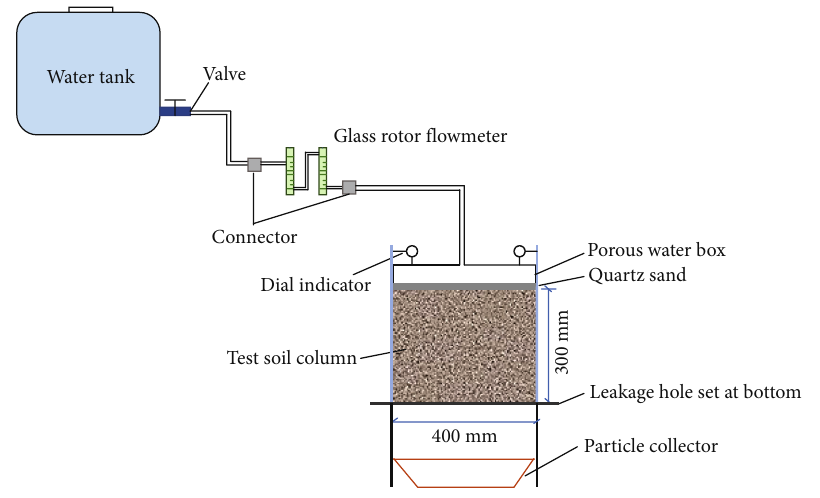
Figure 1: Particle loss test device.